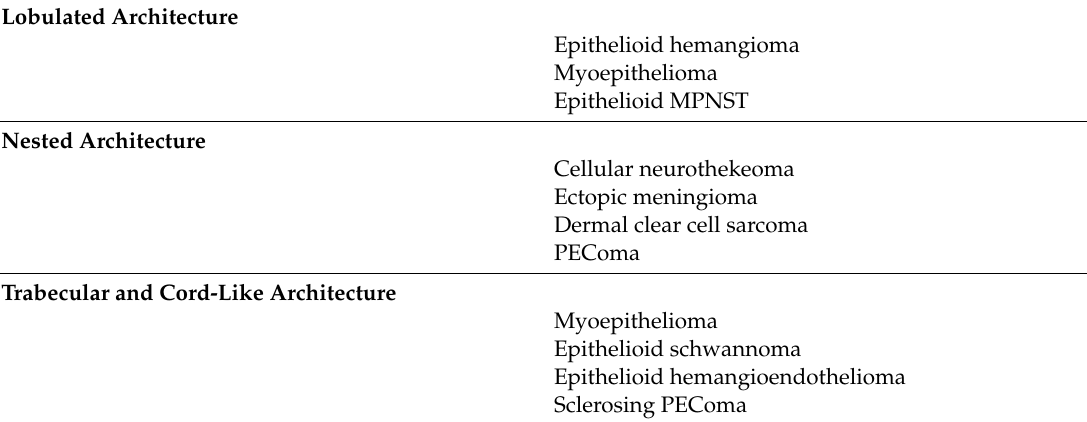
Table 1. Architectural patterns of epithelioid cutaneous mesenchymal